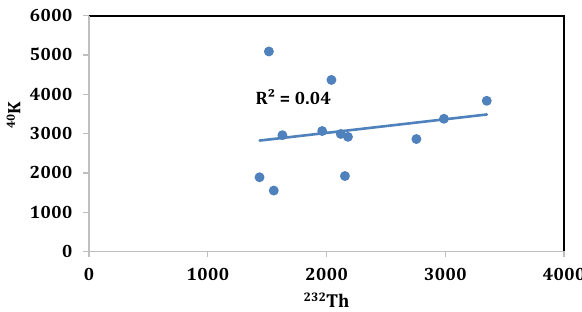
Fig. 5 Activity concentrations (Bq kg −1 ) of 40 K vs 232 Th for different samples